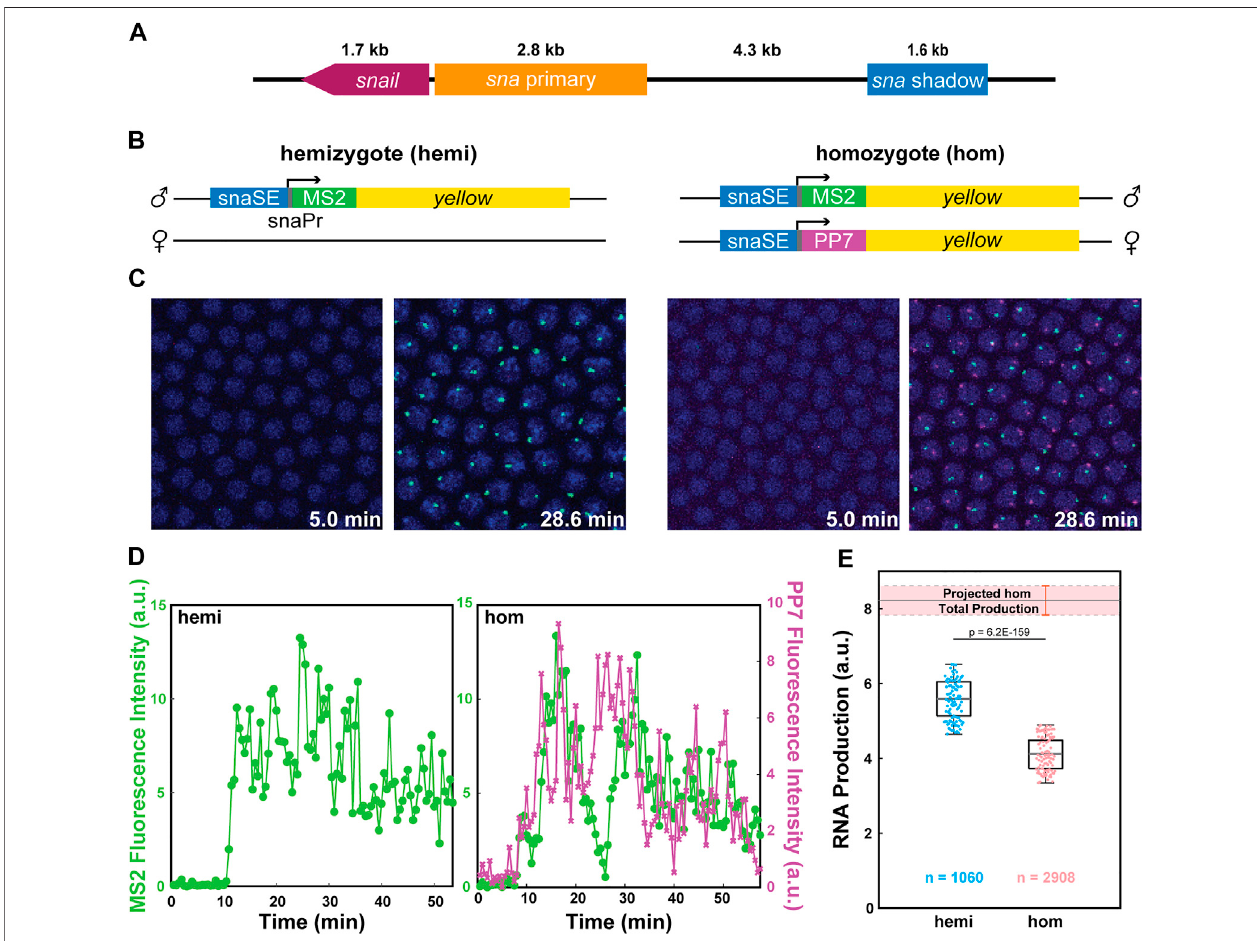
FIGURE1| Alleliccompetitionbetweenthehomologousallelesreducestranscriptionalactivity. (A) Schematicofthe snail gene( sna ),theprimaryenhancer(snaPE), the shadow enhancer (snaSE). (B) Schematic of the hemizygous and homozygous snaSE > yellow constructs. snaSE is placed right upstream of the sna promoter. 24 copies of MS2 and PP7 sequences were inserted for allele-speci fi c visualization of the transcriptional activity. The paternal allele contains the MS2-yellow reporter gene for both hemizygotes and homozygotes. (C) Representative snapshots of hemizygous and homozygous embryos containing the snaSE > yellow transgene. The time indicates minutes after the onset of NC14. Fluorescence puncta (green — MS2-yellow; red — PP7-yellow ) indicate active nascent transcripts. Nuclei were visualized withHis2Av-eBFP2(blue). (D) Representativetranscriptionaltrajectoriesfromanucleusofhemizygousandhomozygousembryosshownin(C).Transcriptionalactivityis proportional tothe fl uorescence intensity. The total RNAproduction ofeach allele can beestimatedby measuring the areaunder thetranscriptiontrajectory. (E) Boxplot showing RNA production of the snaSE > MS2-yellow allele in hemizygous and homozygous embryos. The scatter points show RNA production of two hundred random nucleifromtheanalysis.Theboxplotsshowthatthe MS2-yellow allelefromhomozygotesproducedapproximately25%fewerRNAsthantheonefromhemizygotes.The band above the homozygote boxplot shows the projected total RNA production of a homozygous embryo, which is obtained by doubling the RNA production of one allele in homozygotes. Hemizygotes produce around 70% of the total RNA production of homozygotes. n indicates the number of analyzed nuclei from 4 and 10 biologicallyreplicateembryosofeachgenotyperespectively.Theboxindicatesthe25%,50%and75%quantile,andthewhiskersextendtothe10thand90thpercentile of each